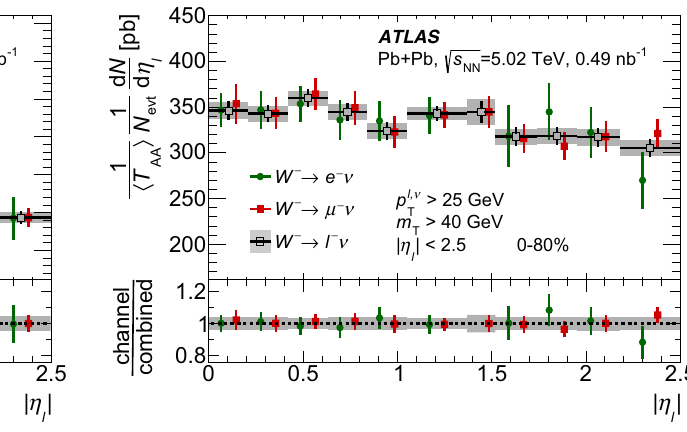
Fig. 7 Differential normalised production yields for W + (left) and W − (right) bosons as a function of absolute pseudorapidity of the charged lepton shown separately for electron and muon decay channels as well as for their combination. Statistical and systematic uncertainties ofthecombinedyieldsareshownasbarsandshadedboxes,respectively. For the individual channels, only the total uncertainties are shown as